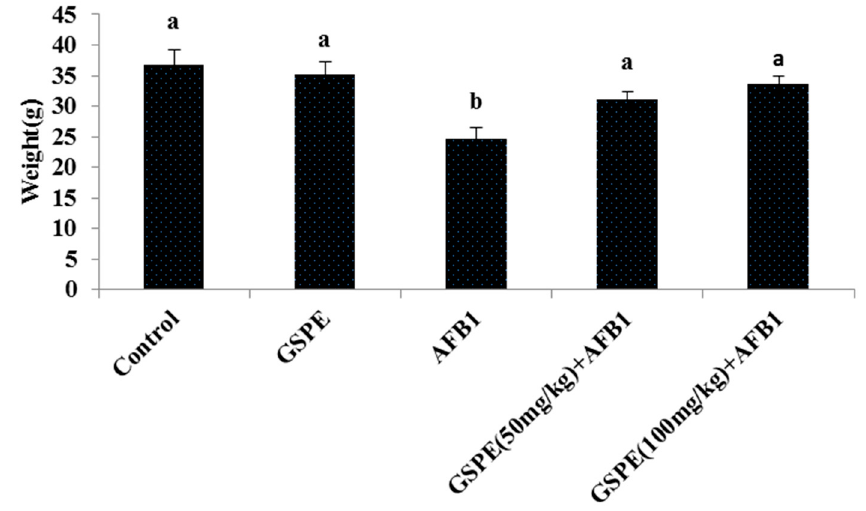
Figure 1. Effect of aflatoxin B1 (AFB1), grape seed proanthocyanidin extract (GSPE) and their co-treatment on weight in mice. Values are mean ± SEM of ten mice in each group. a, b Means with different letters are significantly different ( p < 0.05).